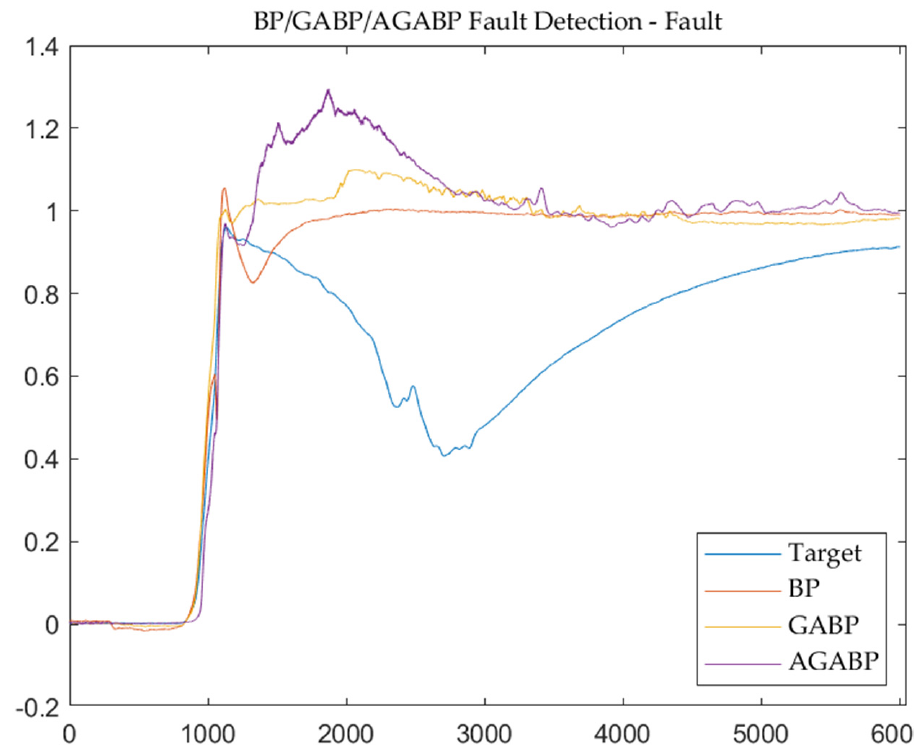
Figure 10. The output of the three models—fault.